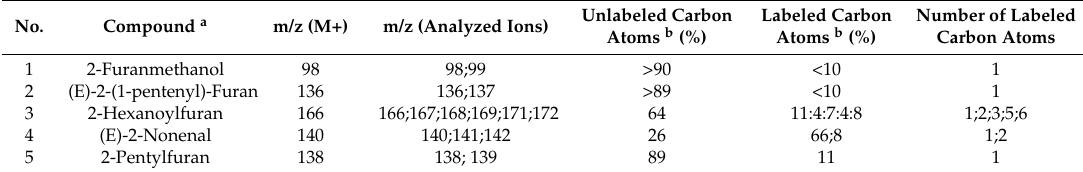
Table 4. Proportion of isotopomers formed from [ 13 C 6 ]glucose and